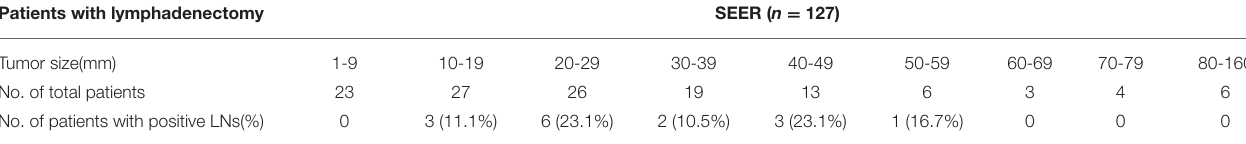
TABLE 2 | Proportion of patients with positive LNs at each tumor size interval. Patients with lymphadenectomy SEER ( n = 127) Tumor size(mm)